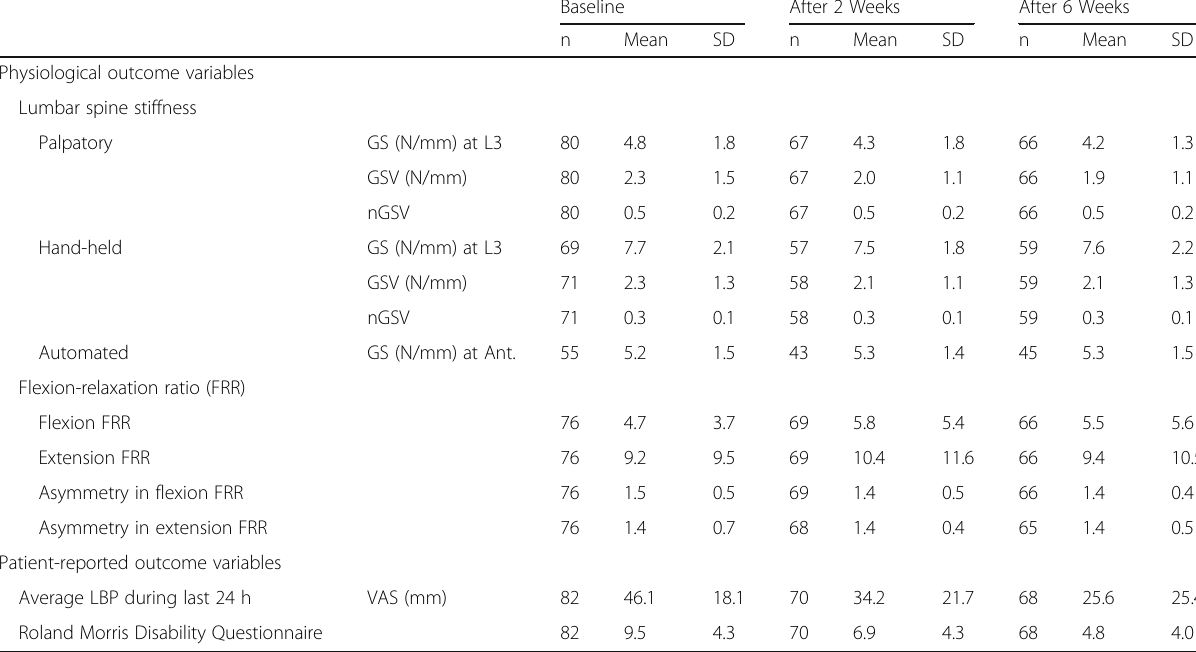
Table 2 Descriptive statistics of physiological and patient-reported outcome variables at 3 assessment time points Baseline After 2 Weeks After 6